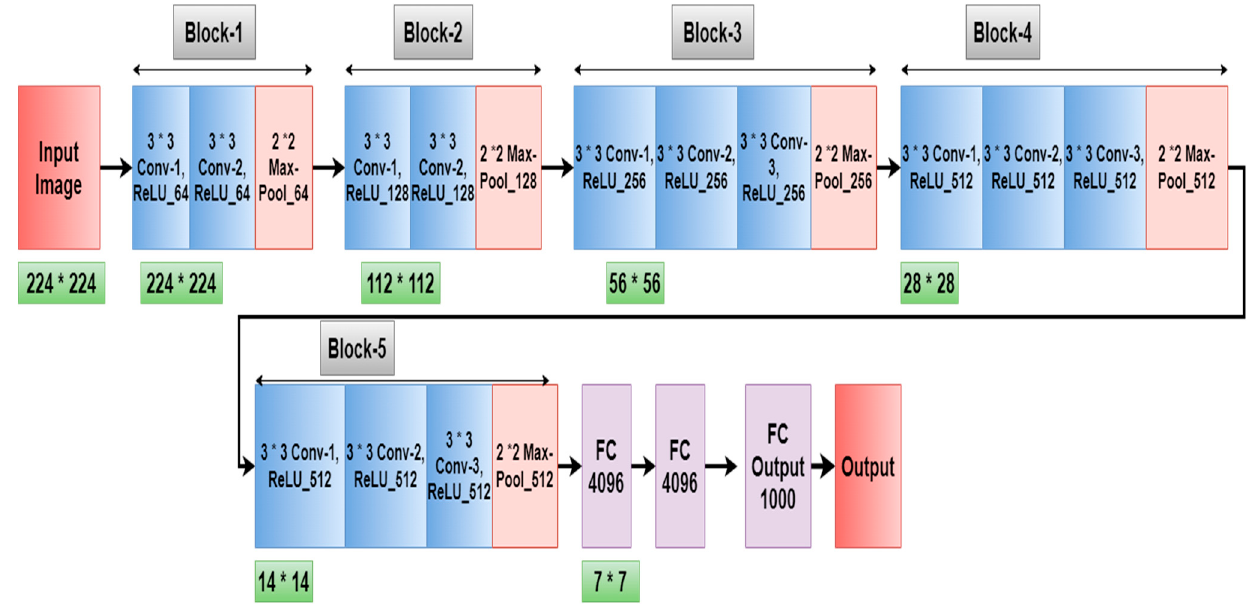
Figure 4. VGG16 Architecture.